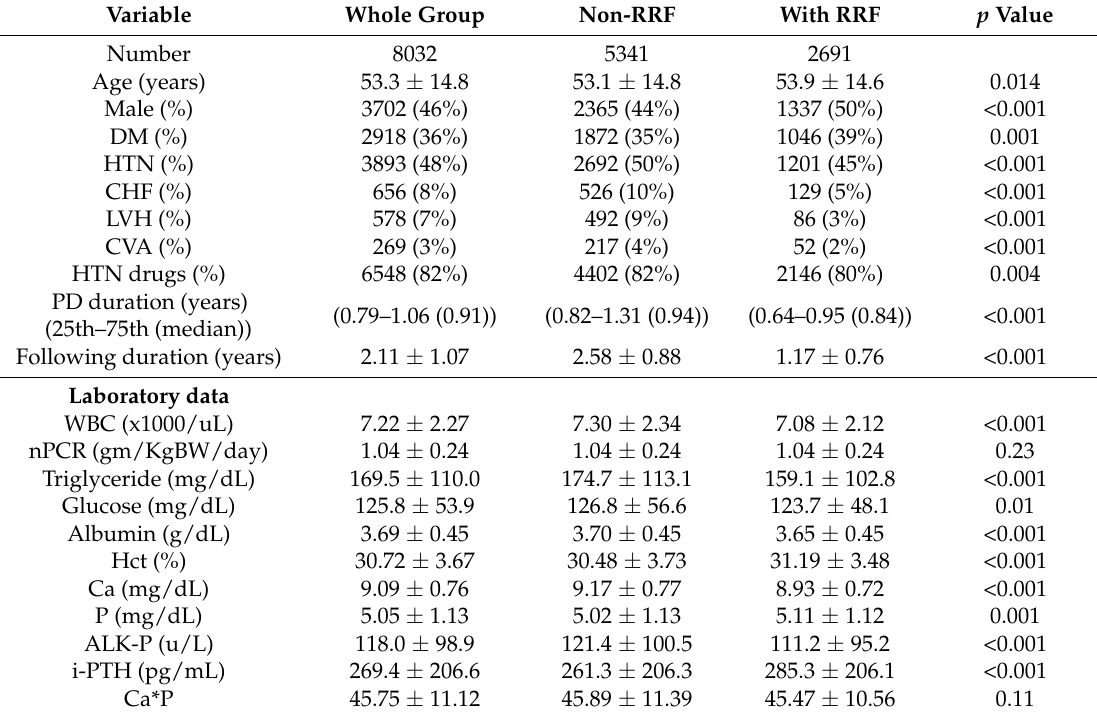
Table 1. Baseline characteristics of 8032 PD patients follow up three years by